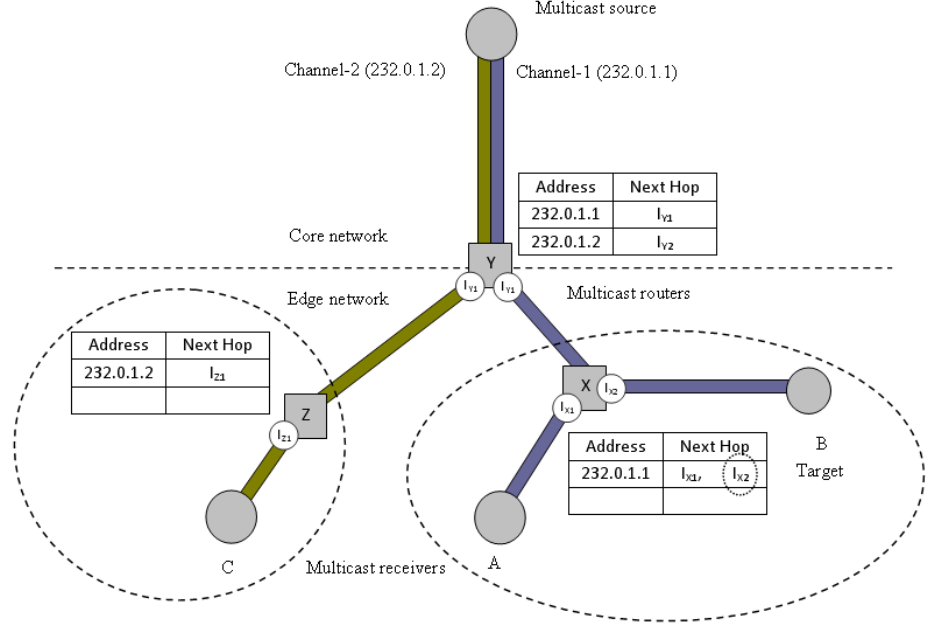
Figure 2. Routing in IP